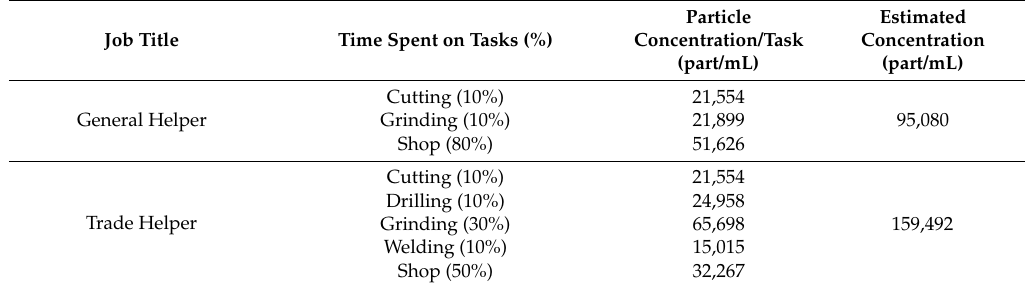
Table 3. Particle Concentration Per Task and Estimated Concentrations Per Job